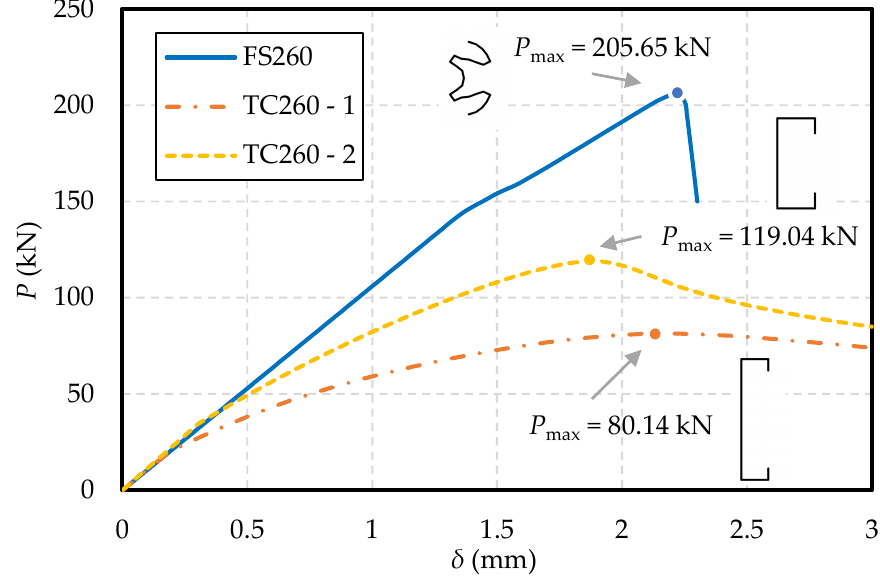
Figure 15. FS260 FE results.